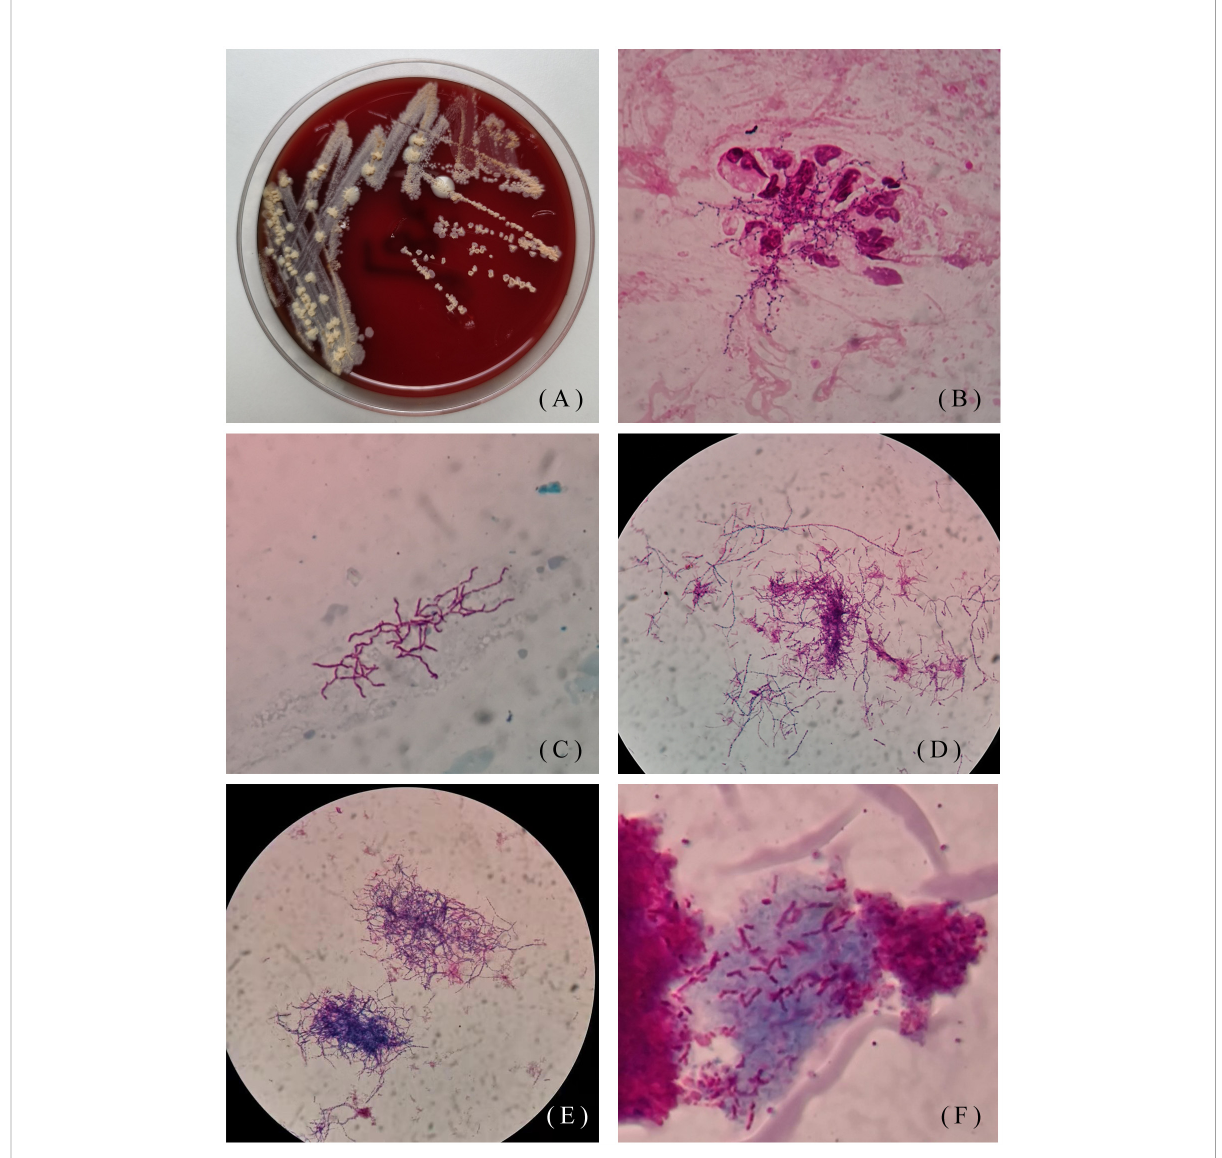
FIGURE 1 Colony morphology of isolate L5.53. (A) Colony morphology of L5.53 on blood agar plates. The colonies were yellow, raised, rough and opaque on blood agar plates; (B) Gram staining of strain L5.53. The sputum samples of strain L5.53 were directly stained with gram. The bacteria were curved and beaded with right-angled branches visible; (C) Acid-fast staining of sputum specimens of isolate L5.53. Acid-fast staining was weakly positive; (D) Acid-fast staining of strain L5.53 after blood plate cultured. Bacterial acid-fast staining was weakly positive, the bacteria became different in length, and the right-angled branches were not obvious; (E) Gram staining of strain L5.53 cultured on blood plates. The bacteria became different in length and branching was not obvious; (F) Strain L5.53 cultured in 960 tuberculosis liquid medium. The strain L5.53 on the blood plate was cultured in 960 tuberculosis liquid medium, and the bacteria were cut short and indistinguishable from